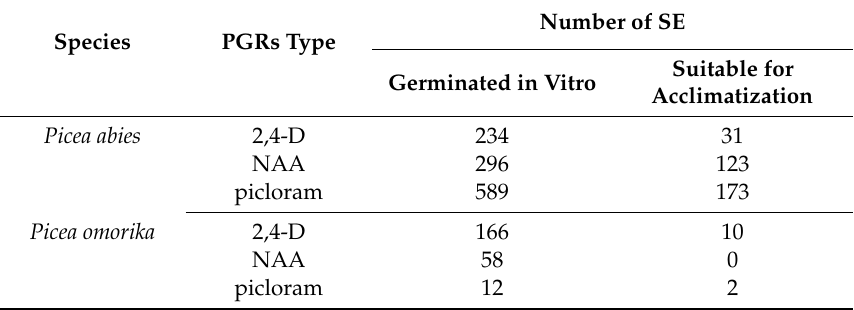
Table 6. Number of somatic embryos classified as suitable for acclimatization obtained from embryogenic lines of Picea abies and P. omorika in relationship to the PGR type used during the induction of the ET